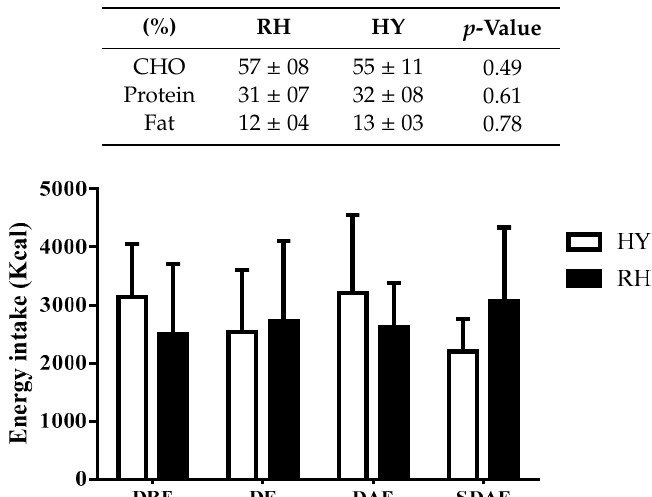
Table 1. Macronutrients intake one day before trials.